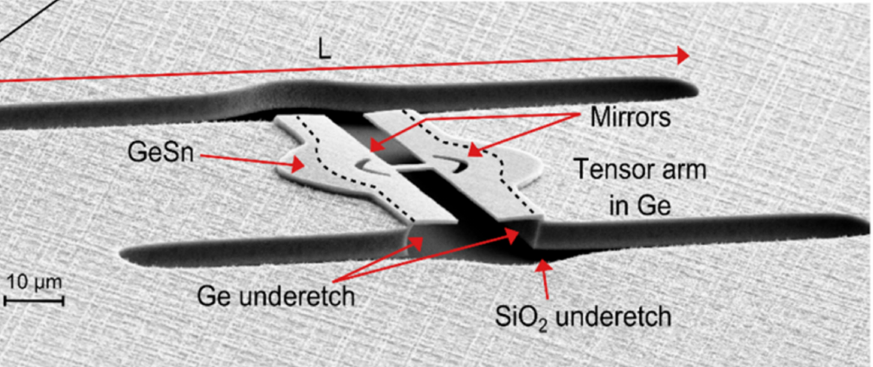
Figure 35. L–L curves for a micro-bridge GeSn laser with an Sn content of up to 16%. Reproduced with permission from [77], American Chemical Society,